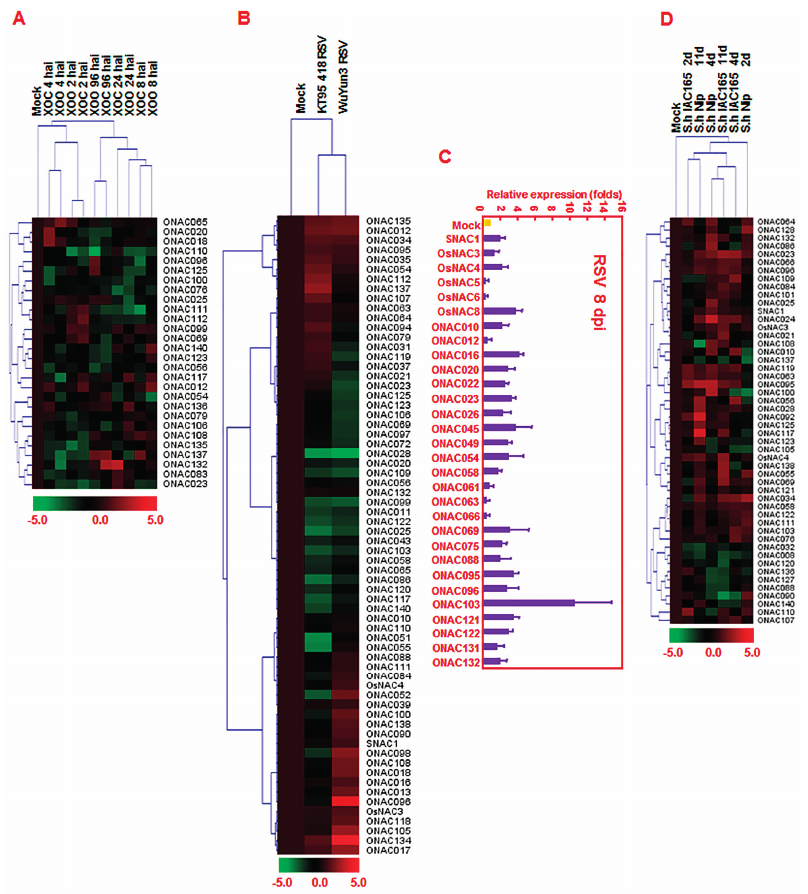
Figure 4. Differential expressions of ONAC genes in response to Xoo , Xoc and RSV. ( A , B ) Heat maps of ONAC genes showing differential expression patterns in rice seedlings after Xoo and Xoc infection and RSV infection, respectively. The change values in treated samples vs. corresponding control, shown as (log 2(signal intensity in treatment/signal intensity in control) = log 2 signal intensity in treatment − log 2 signal intensity in control ), were used for Treeview (Supplementary file 2). The color scale of change values is shown at the bottom; ( C ) Differential expression of 30 selected ONAC genes in rice after RSV infection; ( D ) Heat Map of ONAC genes showing differential expression patterns after infestation by S. hemonthica